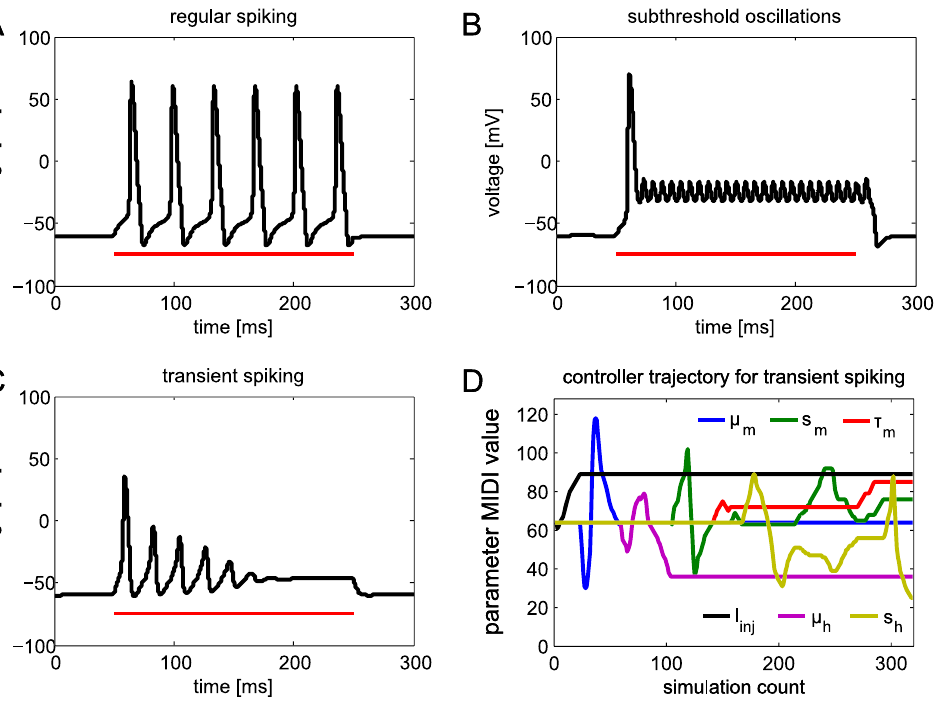
Figure 2. Simulation of the Hodgkin Huxley model with three example parameter sets. The red line shows the duration of the current injection. (A) Regular spiking behavior. (B) A parameter set that leads to subthreshold oscillations. (C) A parameter set that exhibits transient spiking upon current injection. (D) Trajectory of the modified parameters during fitting of the model in C. The ordinate ranges from 0 to 127, the range of control elements on a MIDI controller. The abscissa does not depict absolute time but the simulation